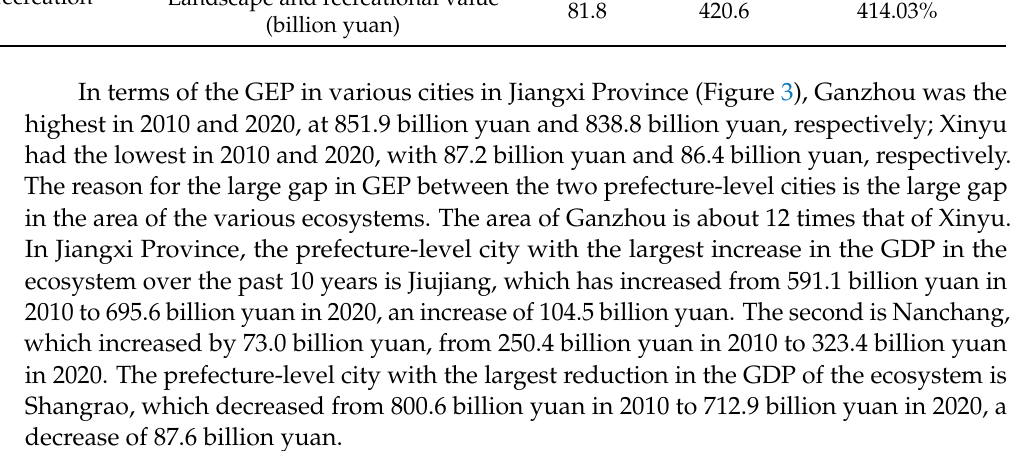
Figure 4. Spatial distribution of GEP per unit area in Jiangxi Province in 2010 and 2020.